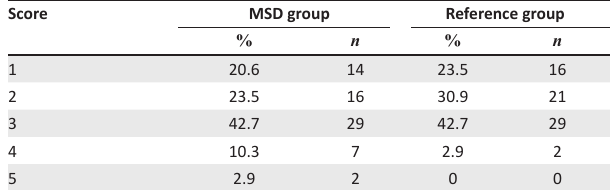
TABLE 4: Final rapid office strain assessment Score for musculoskeletal disorders group ( n = 68) and reference group ( n = 68).